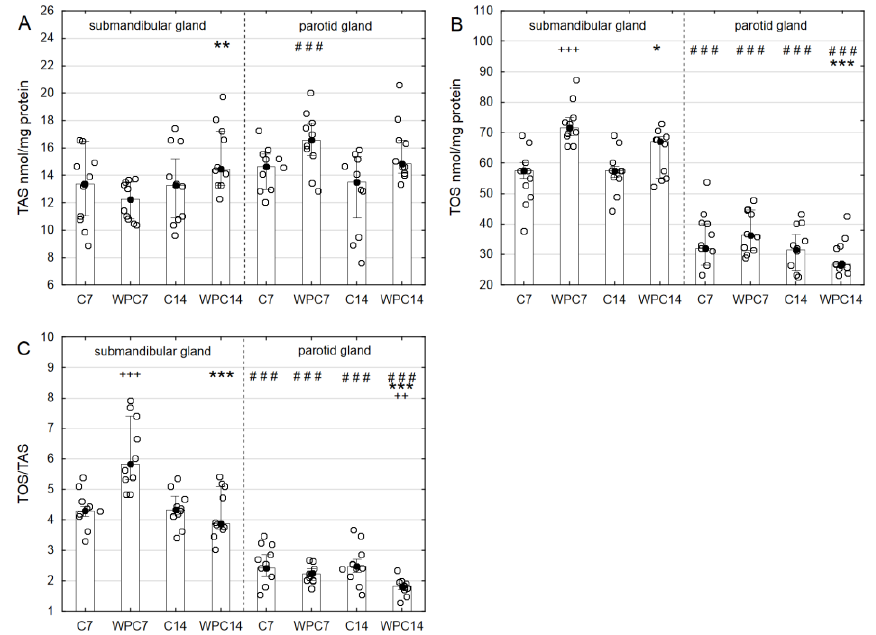
Figure 3. Total antioxidant status ( A ), total oxidant status ( B ) and oxidative stress index ( C ) in the salivary glands of rats from control and experimental groups. Abbreviations: C7, C14, control groups; WPC7, WPC14, experimental groups treated WPC-80; OSI, oxidative stress index; TAS, total antioxidant status; TOS, total oxidant status. Data are presented as a bar chart with the individual data points; +++ p < 0.001 of the C7 submandibular gland, * p < 0.05 of the WPC7 submandibular gland, ** p < 0.01 of the WPC7 submandibular gland, *** p < 0.001 of the WPC7 parotid gland and ### p < 0.001 of the submandibular gland, respectively, for the same groups. Because the results were not normally distributed, the Mann–Whitney test was used to compare differences between the studied groups.